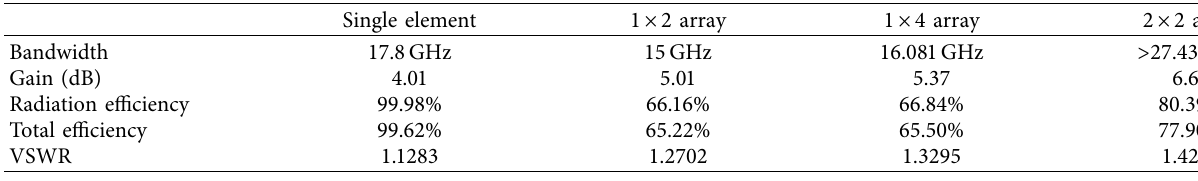
Figure 31: Return loss comparison for different arrangements on (a) XY plane and (b) YZ plane. Table 3: Array comparison.